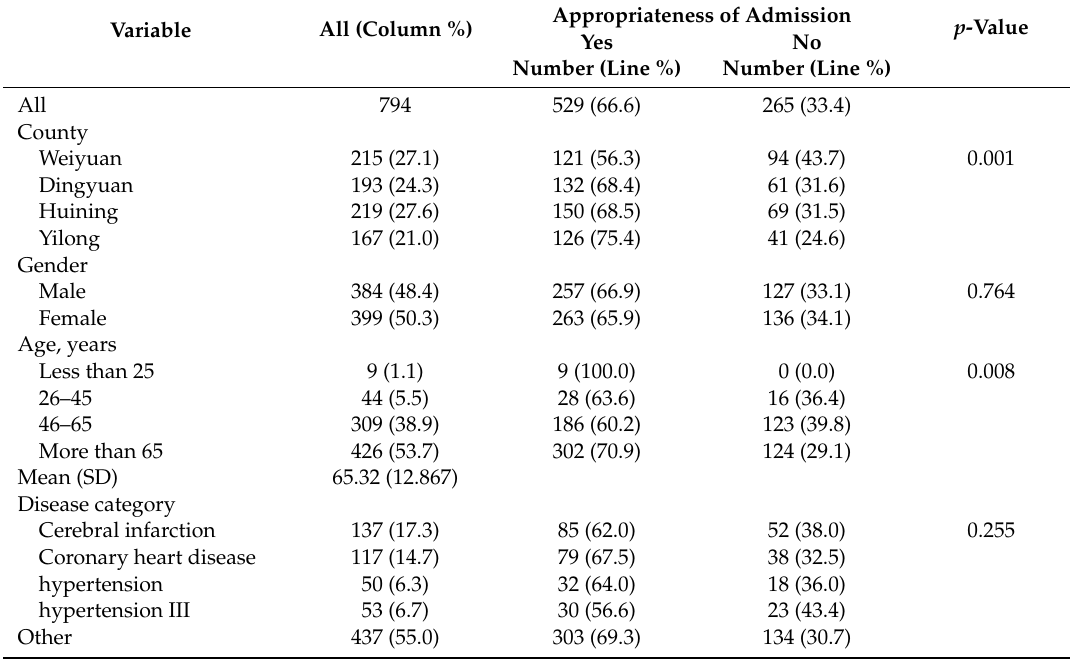
Table 1. Distribution of cases and appropriate admission ( n = 794).